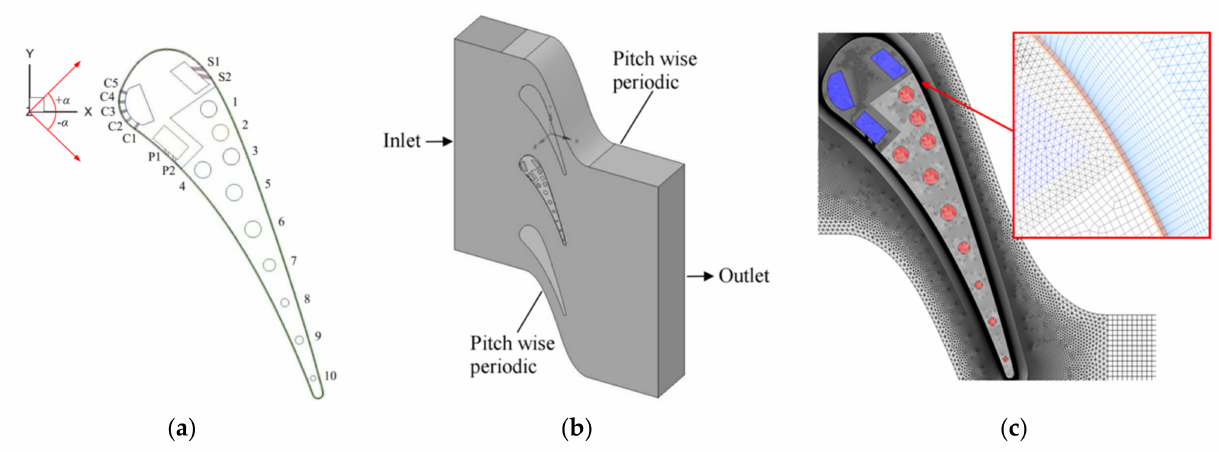
Figure 1. Computational domain and mesh. ( a ) Vane structure; ( b ) Computational domain; ( c )